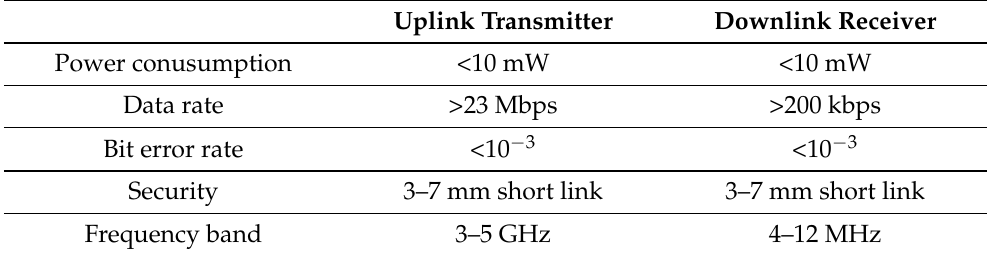
Table 1. Summary of system